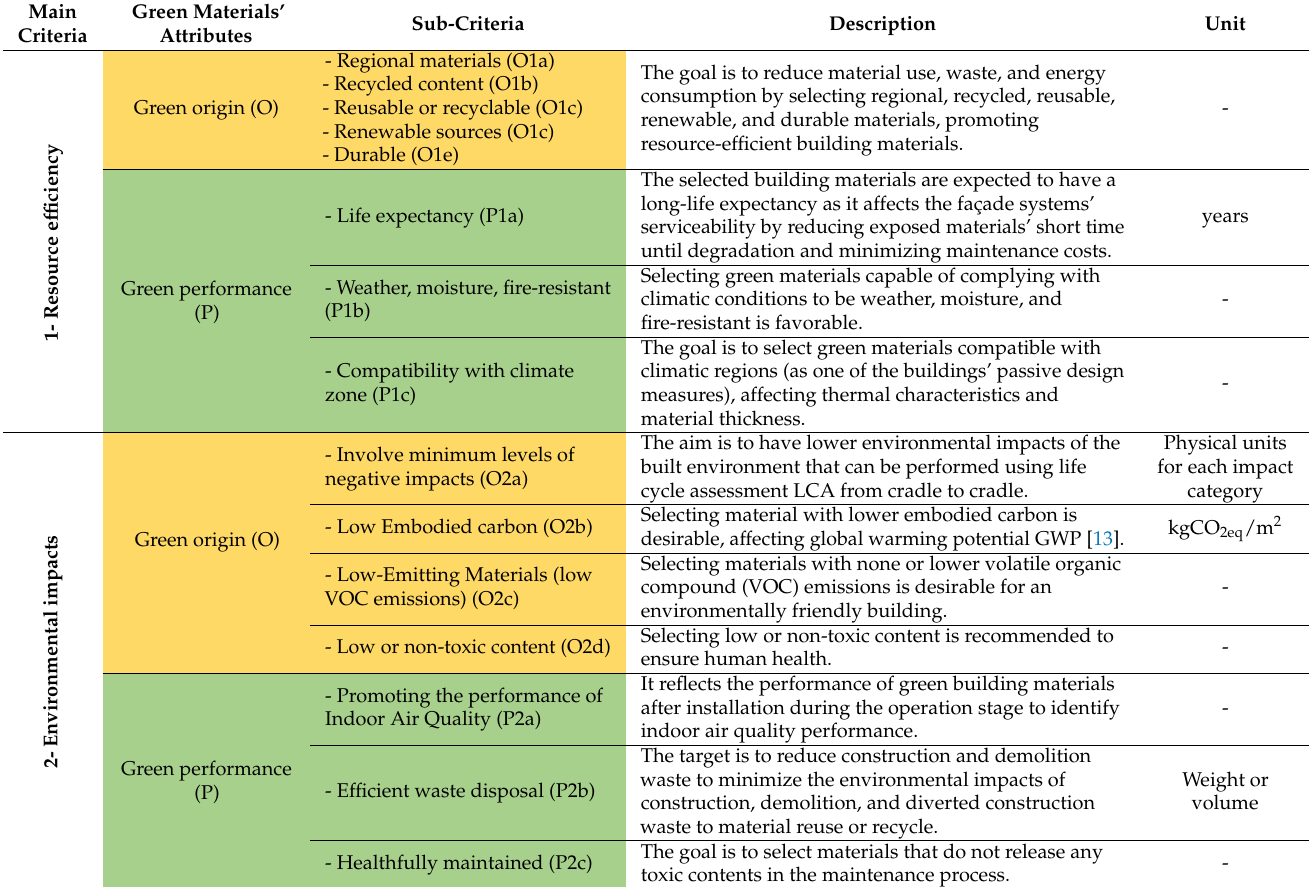
Table 3. Proposed assessment criteria for green building materials and their